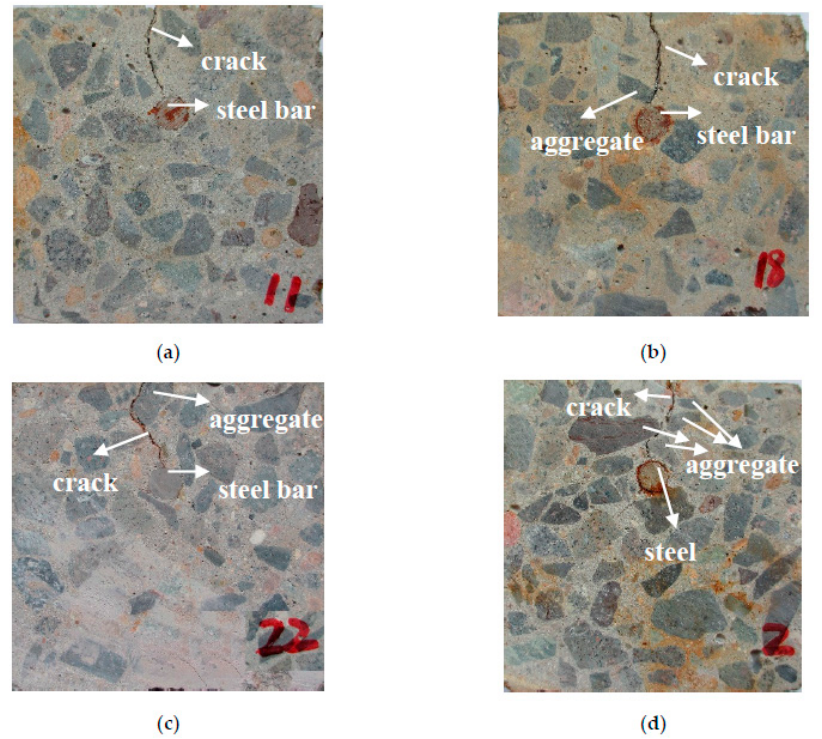
Figure 10. Specified cracking patterns of pattern I: ( a ) Cracking pattern I-1; ( b ) Cracking pattern I-2-1; ( c ) Cracking pattern I-2-2; ( d ) Cracking pattern I-2-3.